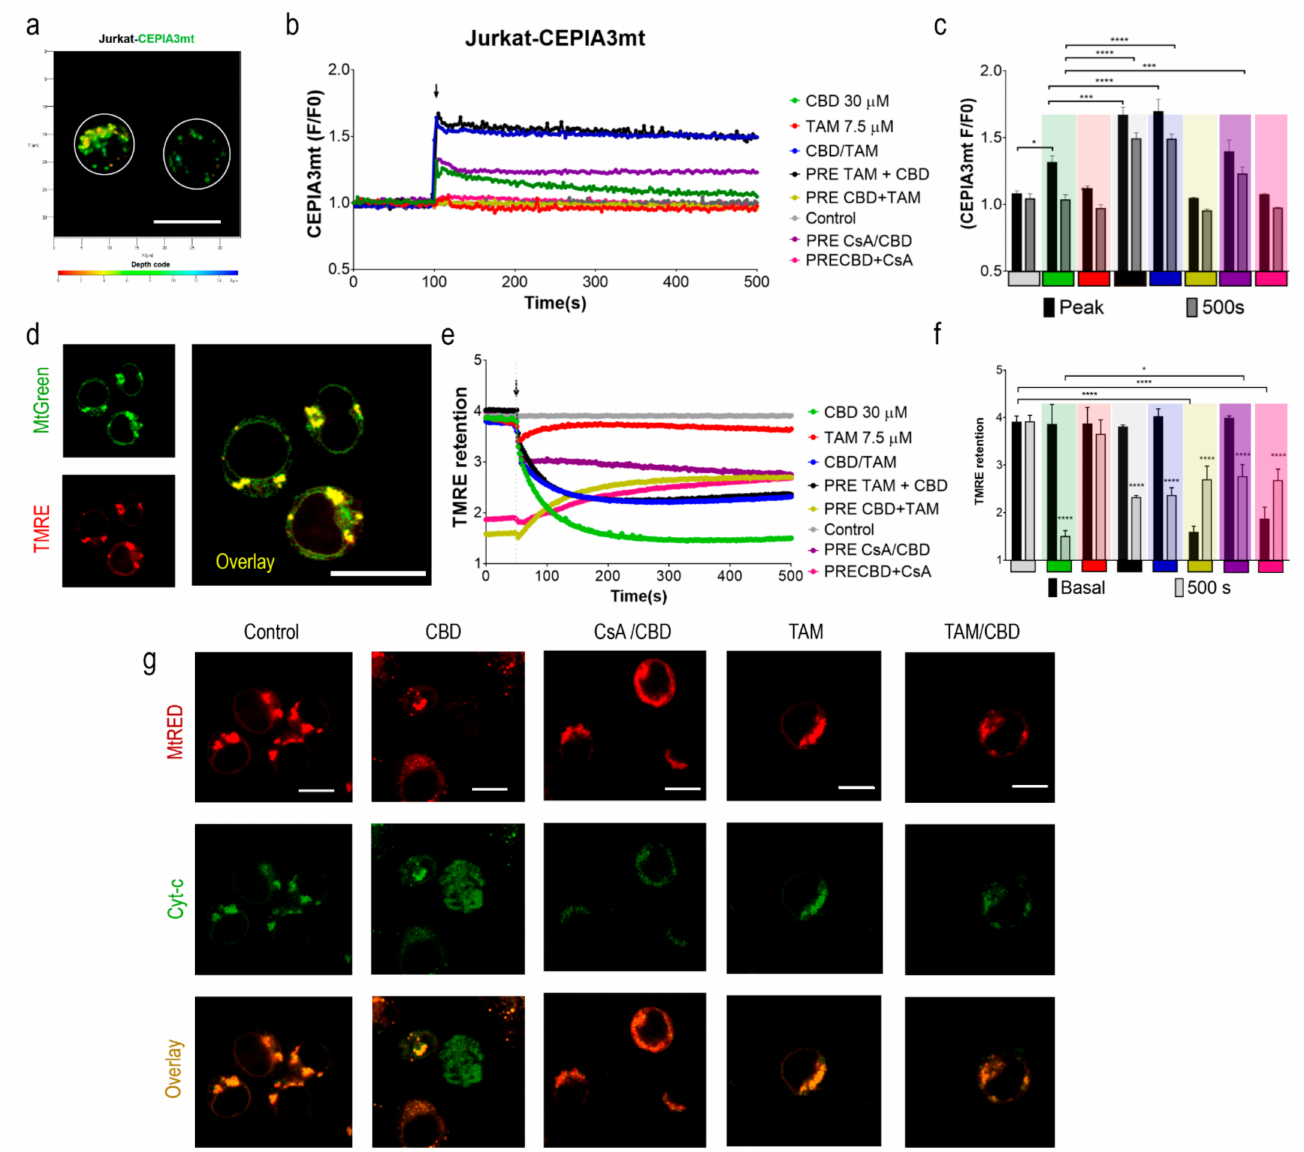
Figure 2. Effects of TAM and CBD on [Ca 2+ ] m and ∆Ψ m in Jurkat cells. ( a ) Representative image of CEPIA3mt-transfected cells, colored puncta are mitochondria. Scale bar is equivalent to 10 µ m. ( b ) Time course of [Ca 2+ ] m changes upon CBD or TAM administration. ( c ) Quantification of the peak value and the [Ca 2+ ] m level at 500 s obtained from transients upon drug administration. Data from every graph represent the average of at least 4 independent experiments. Two-way ANOVA and Sidak’s multiple comparison test were employed to determine statistical differences between groups (color coded to identify compared groups; * p < 0.05; ** p < 0.01; *** p < 0.001; **** p < 0.0001). ( d ) Representative images of TMRE and MtGreen co-stained Jurkat cells evaluated by confocal microscopy, scale bar represents 10 µ m. ( e ) Monitoring of ∆Ψ m upon CBD, TAM or their combinations. Pretreatment was given 20 min before second drug administration. ( f ) Quantification of the basal TMRE retention and TMRE levels upon treatments (initial and at 500 s). Data represent the average of at least 4 independent experiments. Two-way ANOVA and Sidak’s multiple comparison test were employed to determine statistical differences between groups (* p < 0.05; ** p < 0.01; *** p < 0.001; **** p < 0.0001). ( g ) Representative images of Jurkat-EYFP-Cyt-c cells treated with TAM (7.5 µ M), CBD (30 µ M), or TAM + CBD treated cells by confocal microscopy (1 h). Cyt-c distribution corresponds to MtRed staining as multiple discrete puncta. Scale bar corresponds to 10 µ m. CBD administration caused a rapid decrease of the TMRE fluorescence intensity, indicating the collapse of the ∆Ψ m (Figure 2e; green trace). A preincubation with CsA (10 µ M, 20 min) limited the CBD-induced ∆Ψ m loss (Figure 2e, purple trace).